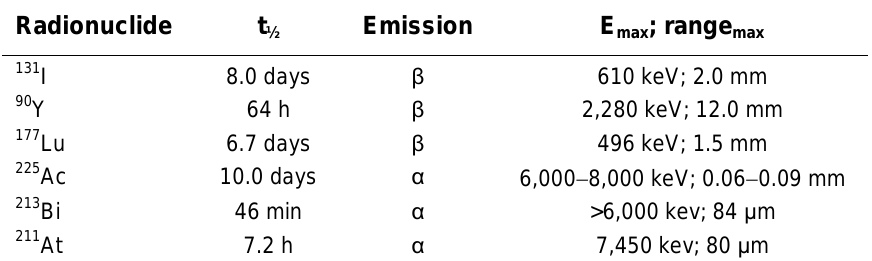
Common α - and β -Emitting Radionuclides Used in RAIT